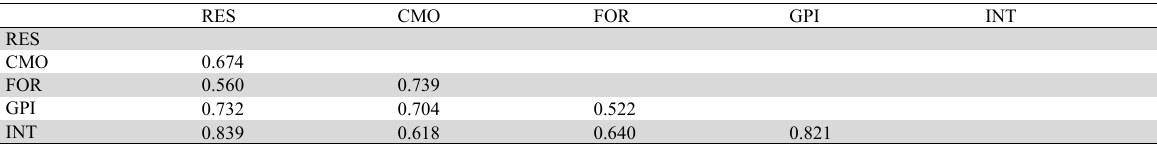
RES CMO FOR GPI INT